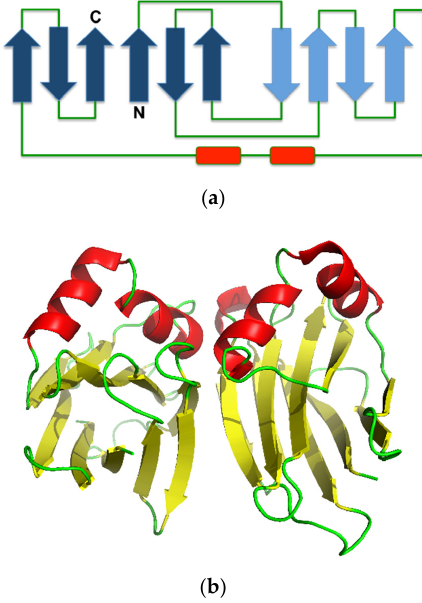
Figure 4. ( a ) Secondary structure topology of ABL. The pleated forms indicate the arrangement of the β -strands assembly. ( b ) Cartoon presentation of the crystal structure of ABL (Protein Data Bank (PDB) ID: 1Y2T). The structure was obtained from the Protein Databank and the three-dimensional structure figure was prepared using PyMoL [44]. The secondary structure topology was manually prepared using the three-dimensional structure as the